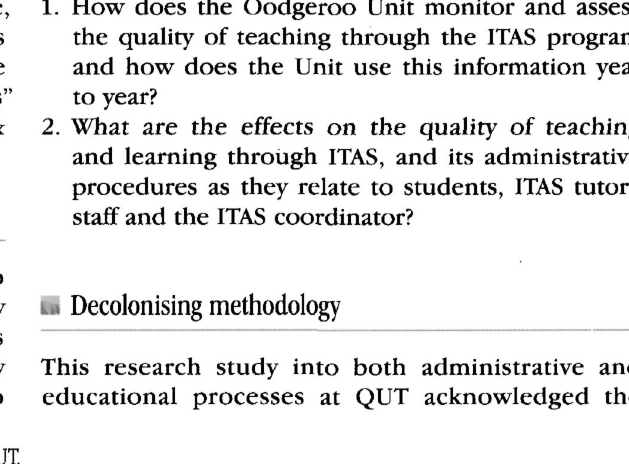
Table 1.2007 students accessing ITAS tutoring within the Oodgeroo Unit,